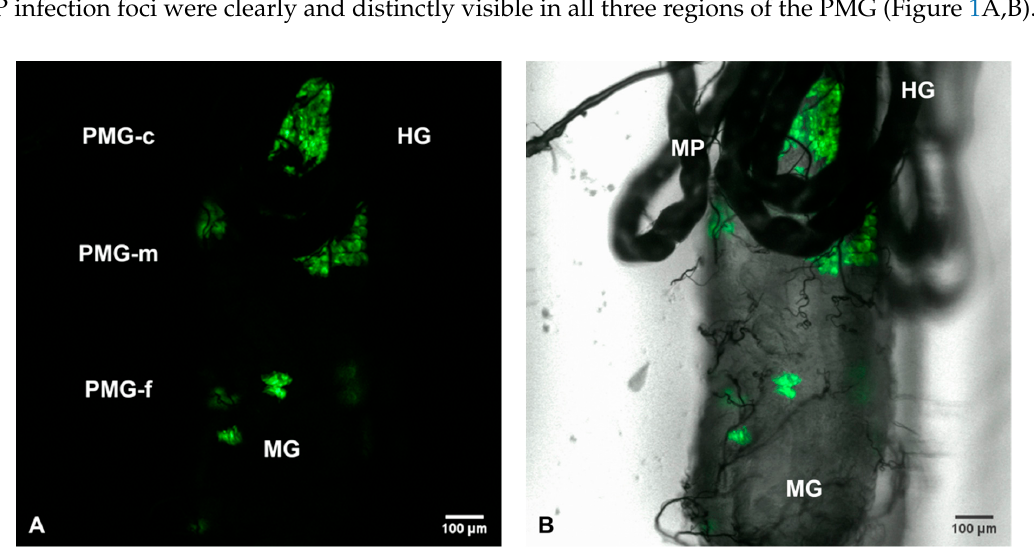
Figure 1. ( A ) Fluorescent laser confocal image and ( B ) bright field overlay of multiple SINV-TaV-GFP infection foci in the MG of Ae. aegypti on day 5 p.i. following a viremic bloodmeal. Six SINV infection foci are observed as green fluorescent clusters. Posterior midgut (PMG) regions identified are ( A ) PMG-frontal (PMG-f), PMG-middle (PMG-m) and PMG-caudal (PMG-c). HG, hindgut; MP, Malpighian tubules; MG, midgut. 100×.